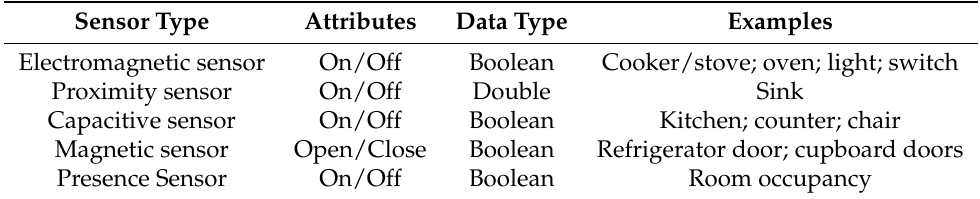
Table 7. Smart Home Sensors.